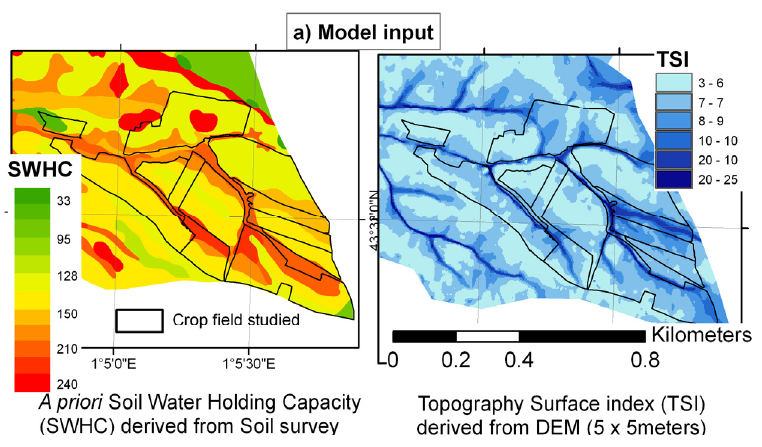
Figure 2. Cont. Figure 2.